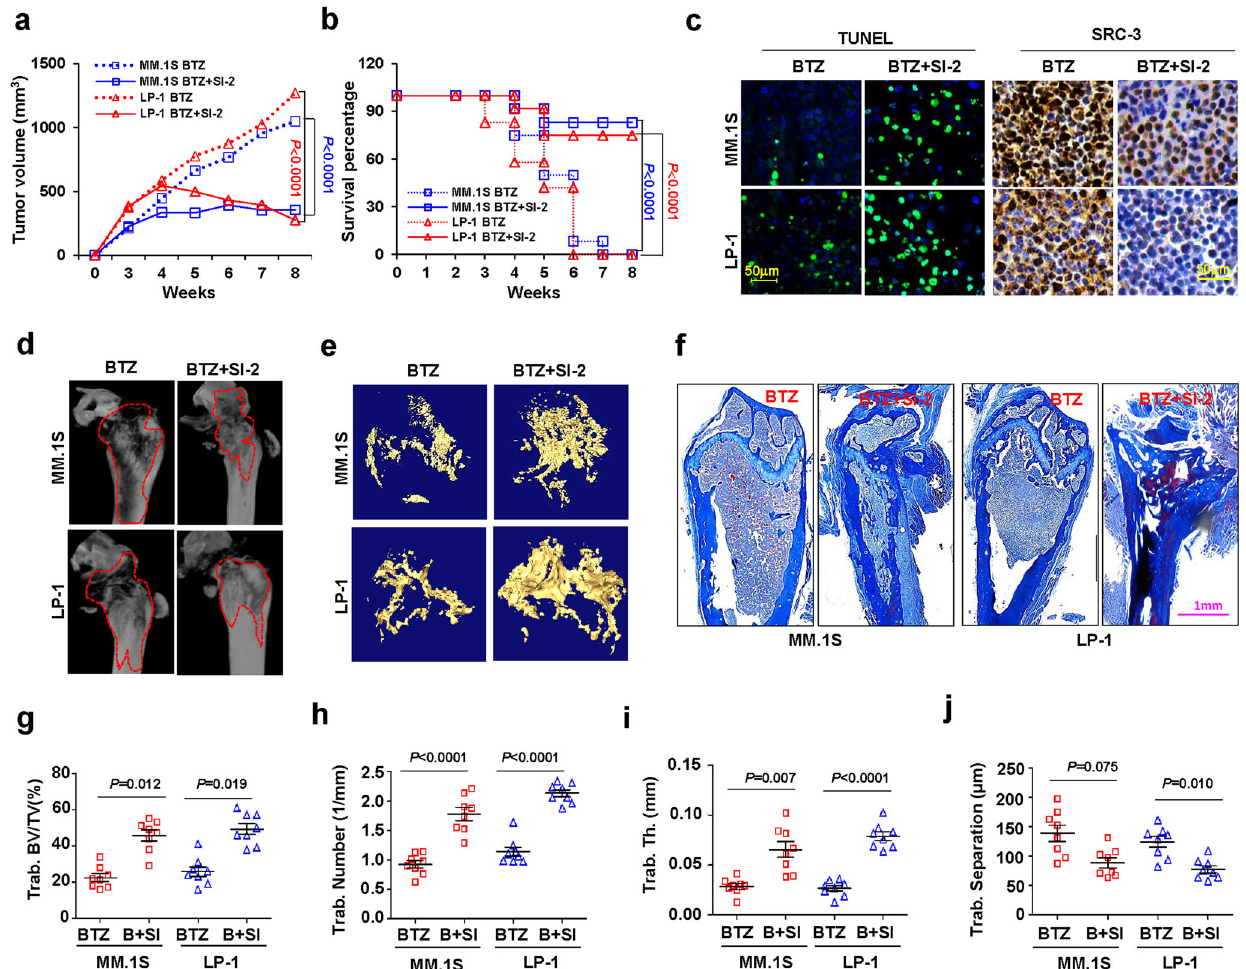
Fig. 7 SI-2 abolishes BTZ drug resistance and rehabilitates bone disruption in vivo. a Tumor growth of bortezomib (BTZ)-resistant (BR) MM.1S or LP-1 cells (3 × 10 6 cells/mouse) in NSG mice combined treatment with SI-2 and BTZ ( n = 12 mice per group). Two-sided P -values were determined by two-way ANOVA test; mean ± s.d.; red P for LP-1 and blue P for MM.1S. b Survival rate of mice at the time point of tumor size = 15 mm 3 ( n = 12 mice per group). Two-sided P -values were analyzed using log-rank test; red P for LP-1 and blue P for MM.1S. c Representative micrographs ( n = 12 biologically independent samples) of immunohistochemistry staining in tissues from xenograft of mice treated with bortezomib (BTZ) or BTZ plus SI-2 to detect SRC-3 level and apoptosis using TUNEL kit. Scale bar, 50 μ m. d Representative microCT reconstructions of mouse femurs bearing bortezomib (BTZ)-resistant (BR) MM.1S and LP-1 cells (5 × 10 5 /mouse) and treated with BTZ (0.5 mg/kg) or BTZ + SI-2 (2 mg/kg SI-2) (n = 8 mice per group). e 3D reconstructions of